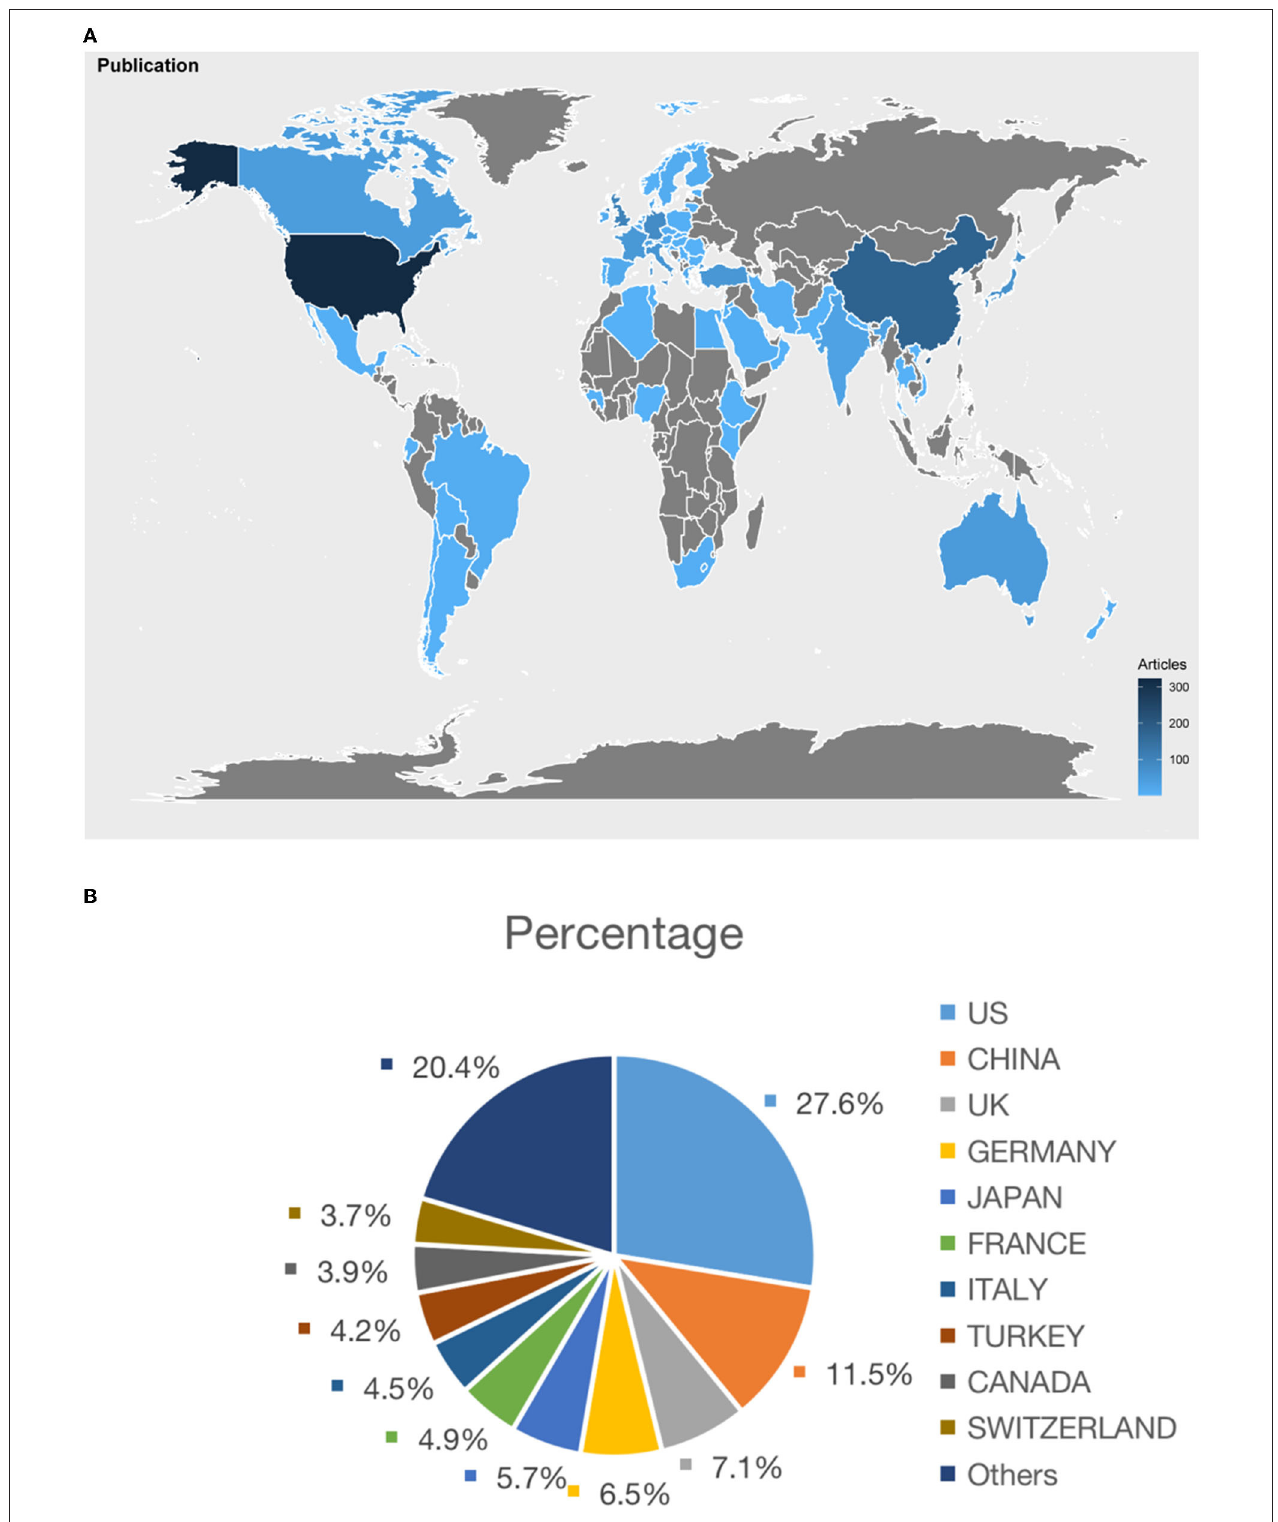
FIGURE 3 | (A) The regional distribution. (B) Distributions and percentages of countries/regions of publications.